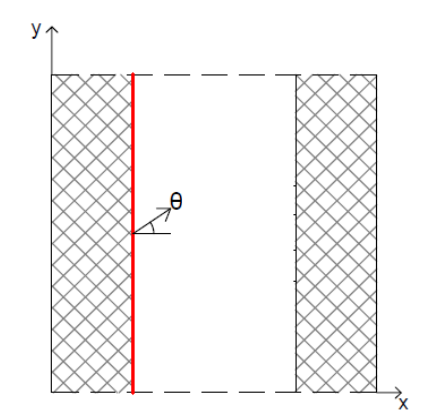
Figure 1. MILDwave wave generation technique by [32] employed in the MILDwave-NEMOH coupled model. The internal wave generation line is marked using a red line. The period lateral boundaries are indicated by black dashed lines. Figure adapted from [32].